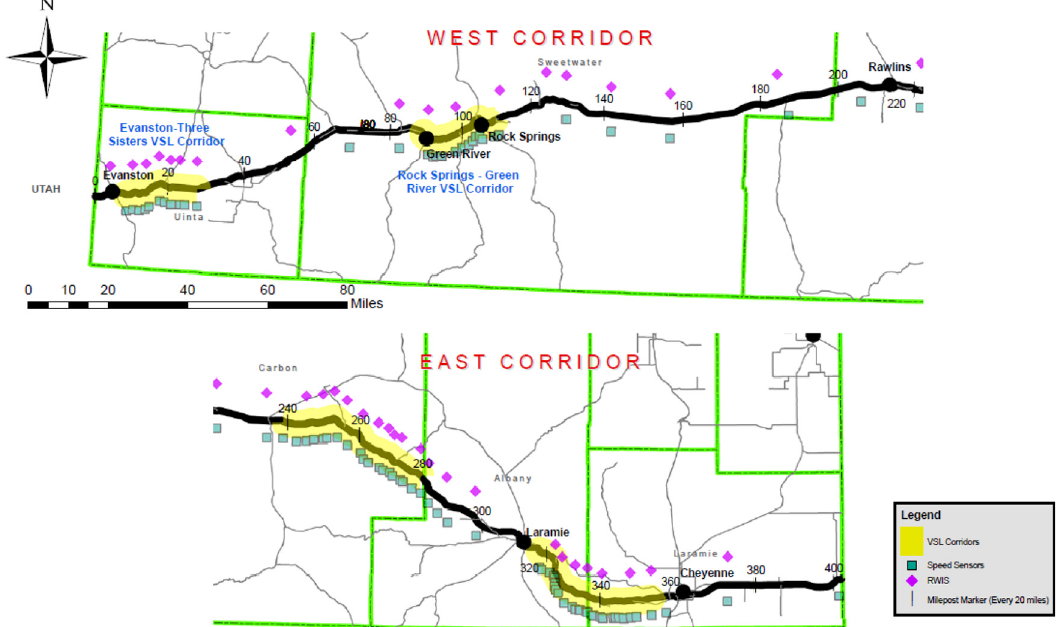
Figure 9 Location of Speed Sensor, RWIS, and VSL Corridors on Wyoming I-80 (Kitchener et al. ,